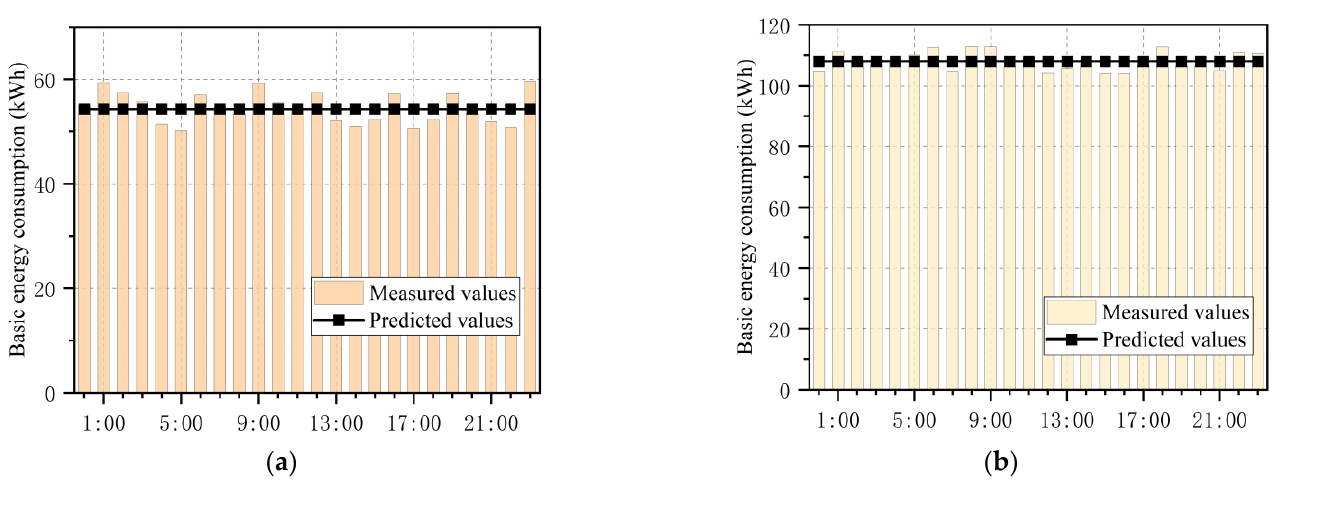
28 of 34 Figure 21. Correspondence between building area and base energy consumption for different types of office buildings. As can be seen from Figure 10, there are huge differences in the basic energy con- sumption of different types of office buildings, probably due to different office intensities, different staff densities, and different power-consuming equipment. Fitting by SPSS, the corresponding relationship between the basic energy consumption and building area show an approximate linear correlation. The area-based index relationship of the eight office buildings applicable to this study is shown in Equation (16).